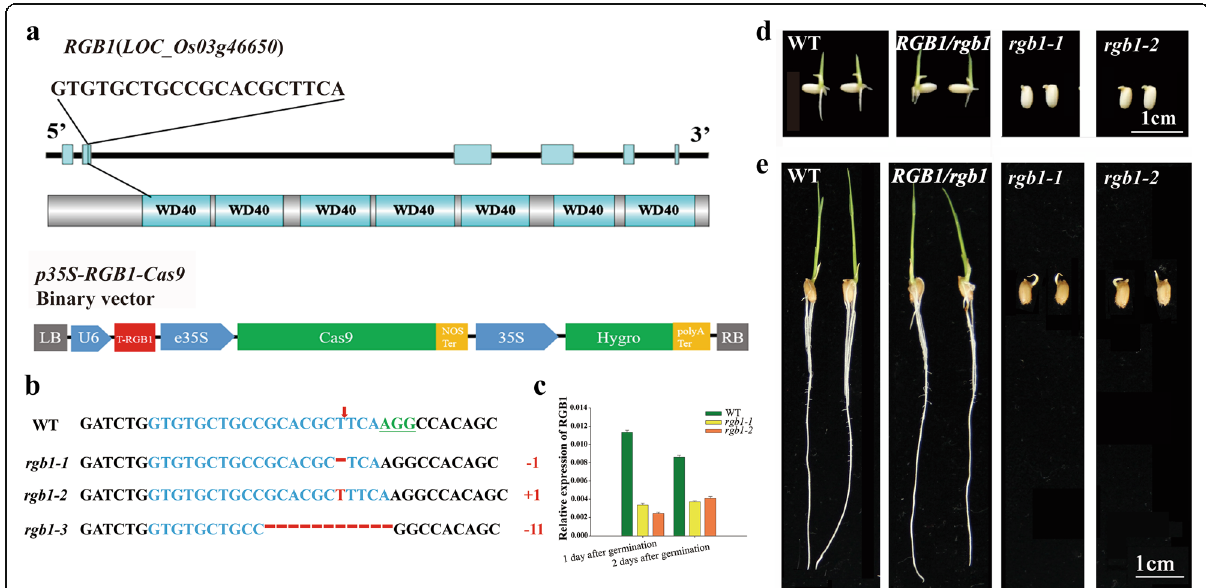
Fig. 1 Characterization of the rgb1 mutants generated using CRISPR/Cas9 in rice. a Schematic diagram of the genomic region and the predicted protein structure of RGB1 and the target guide sequences are labeled in black uppercase letters. The structure of the p35S-RGB1_Cas9 vector is shown at the bottom of the panel. b Sequence alignment of the rgb1 mutants showing altered bases compared to the reference genomic RGB1 sequence. The red arrow indicates the cleavage sites. The targeted sequence is highlighted in blue, and the protospacer adjacent motif (PAM) sequences are marked in green and underlined. Indels are indicated by red letters (insertions) or dashes (deleted nucleotides). c Real-time RT-PCR analysis of RGB1 transcripts in the embryos of the WT and rgb1 mutant lines during the early stages of postgermination growth. The PCR signals were normalized to those of actin transcripts. The data are presented as the means±SDs. ( n = 3) ( d-e ) Comparison of seedlings of the rgb1 mutant, RGB1/rgb1 mutant and wild type. d Germinated dehulled seeds growing on filter paper atop wet sand for 5 days after germination. e Germinated seeds growing on plates containing distilled water for 5 days after germination. The white scale bars represent 1 cm (dehulled) from the SG948 – 6 and SG948 – 8 lines in the viable in these lines (Additional file 1: Figure S1a-d). More T2 generation were germinated and grown for 1 week. than 90% of the seeds showed good grain plumpness, and The germination efficiency of the dehulled grains and normal shoot and root structures had developed from the seeds ranged from 58.33% to 65.0% and from 72.57% to embryos on day 18 after flowering (Additional file 1: 75.69%, respectively (Table 1). The segregation ratios of Figure S1e-h). To identify the genotype, seeds and grains Table 1 Germination efficiency in T2-generation p35S-RGB1-Cas9 (Aa) and WT (Aa, RGB1 heterozygous mutants). (NG: Number of seeds, NGS: Number of germinated seeds, NNGS: Number of nongerminated seeds, GE: Germination efficiency) WT SG948 – 6